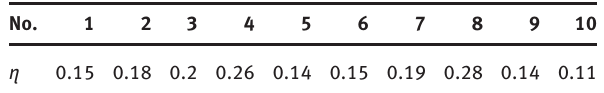
Table 5: Viscosities calculated by self-diffusion coefficients /(Pa·s). No.